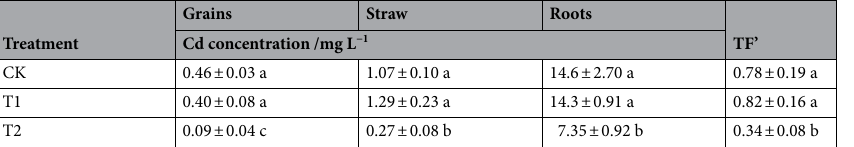
Table 3. Cd concentrations in the roots, straw and grains of rice and its translocation factor from roots to shoots. Different letters represented significant difference at P < 0.05.